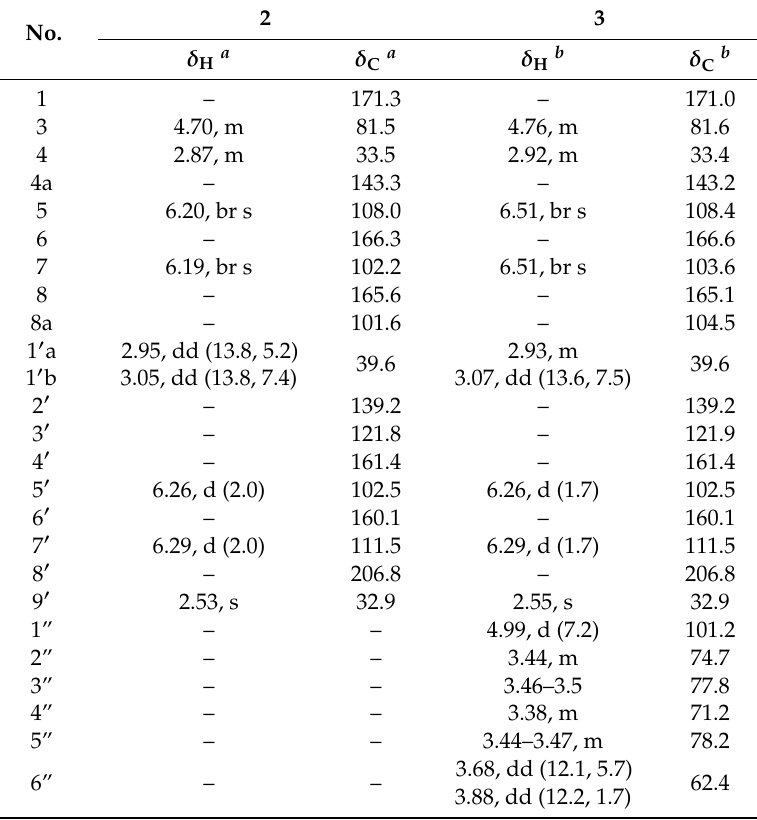
Table 1. 1 H and 13 C NMR spectroscopic data for compounds 2 and 3